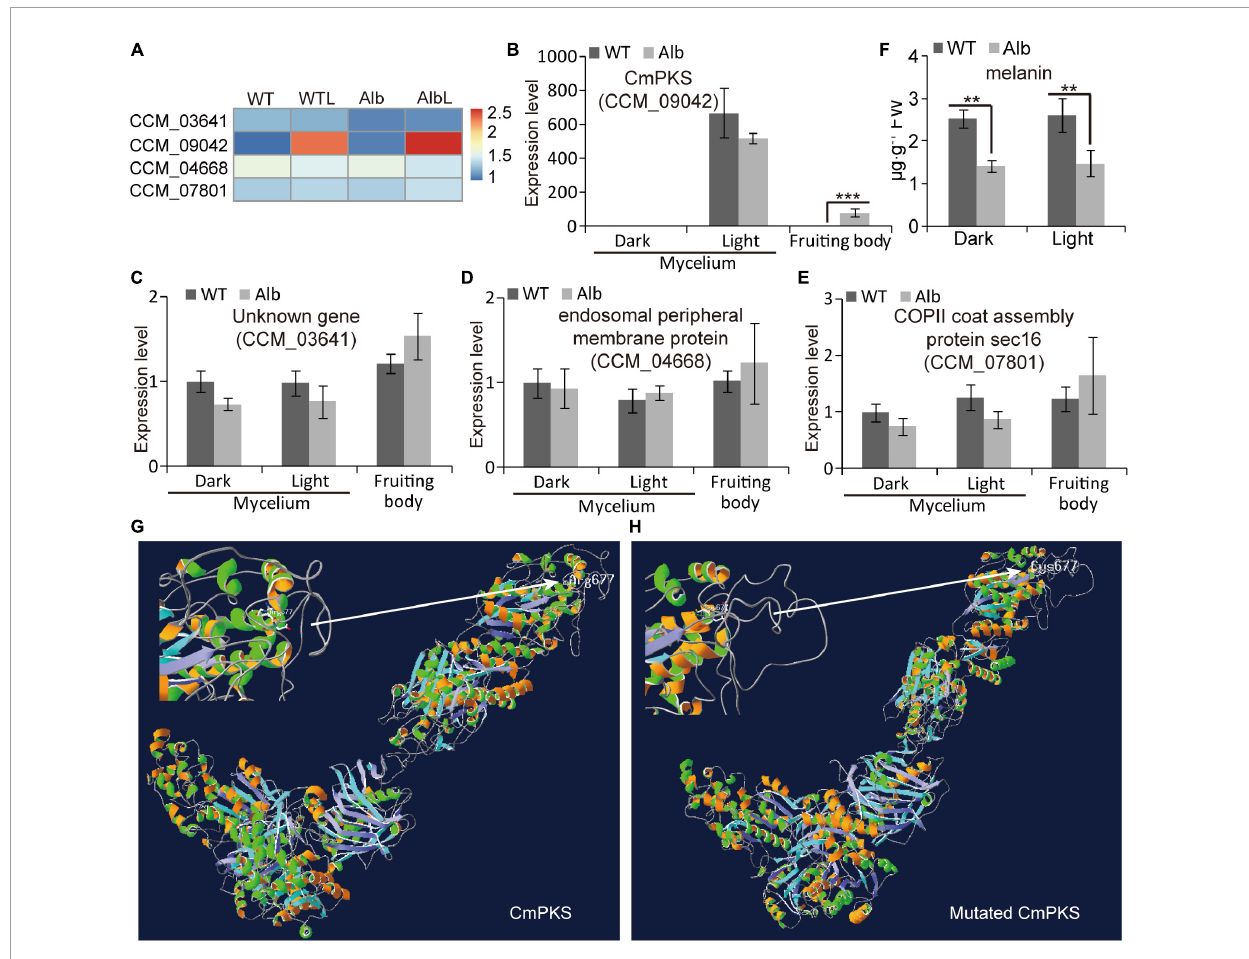
FIGURE5 Expression analysis of four mutated genes under dark and light treatment. (A) Heatmap analysis of CCM_03641, CCM_09042, CCM_04668, and CCM_07801 based on their FPKM values in the WT, WTL, Alb , and AlbL samples; (B–E) expression analysis of the four genes in the mycelia under dark and light treatment, and fruiting body; (F) compare of melanin content between WT and Alb mycelia under dark and light conditions; (G,H) 3D model of the normal and mutated CmPKS proteins. Two asterisks denote significance relative to WT (Student’s t -test; ** p <